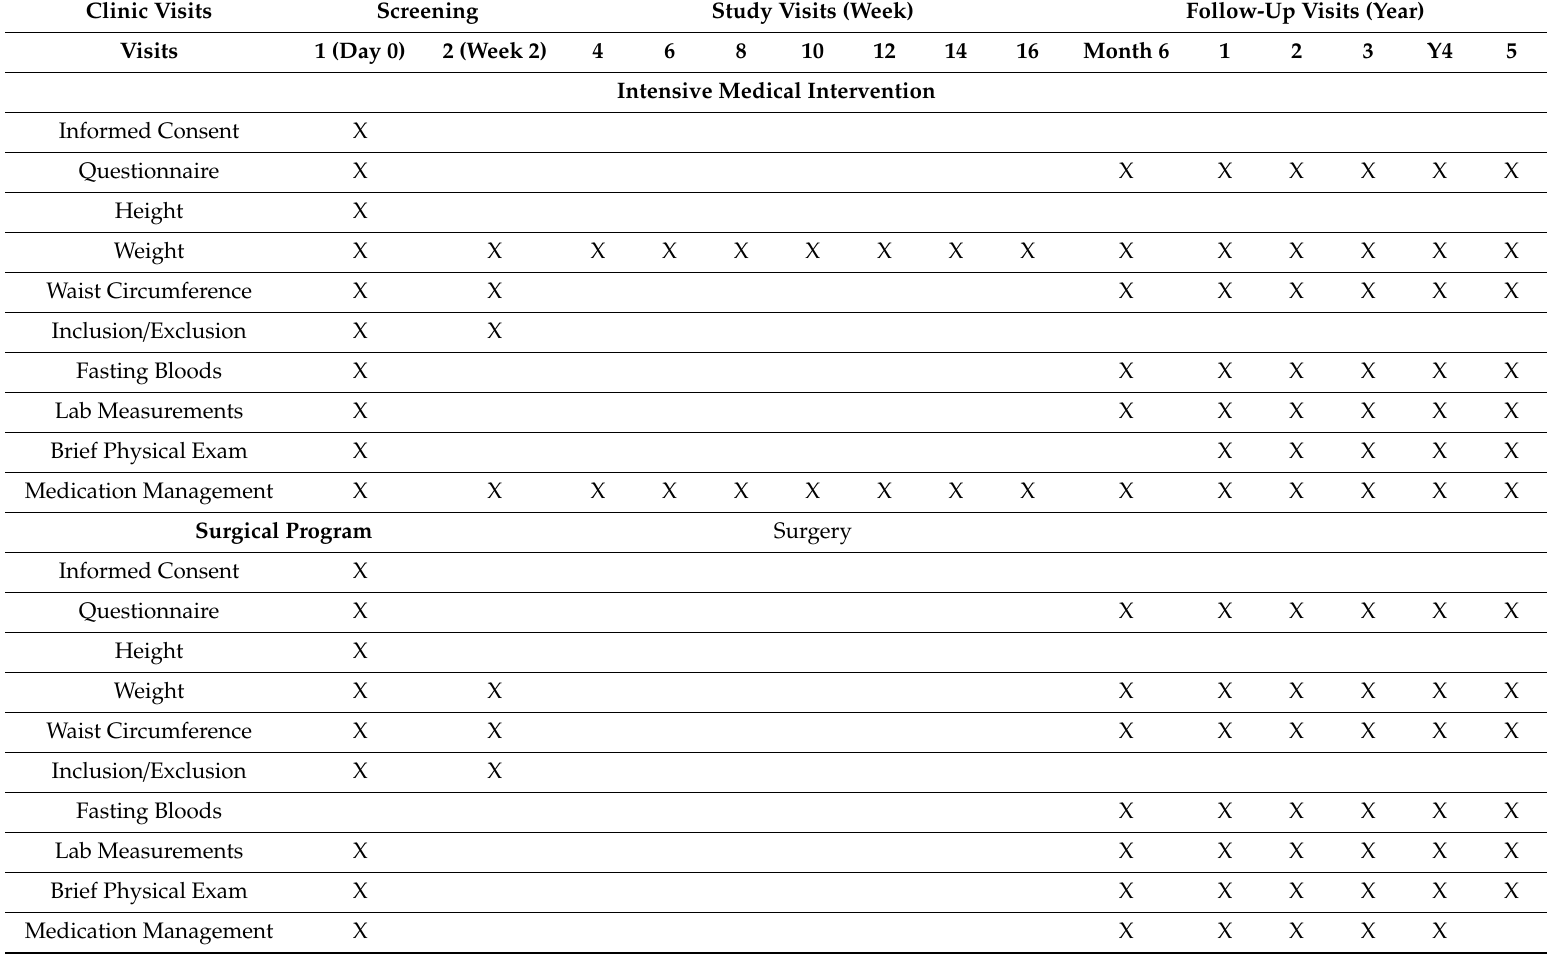
Table 3. Participant schedule of study